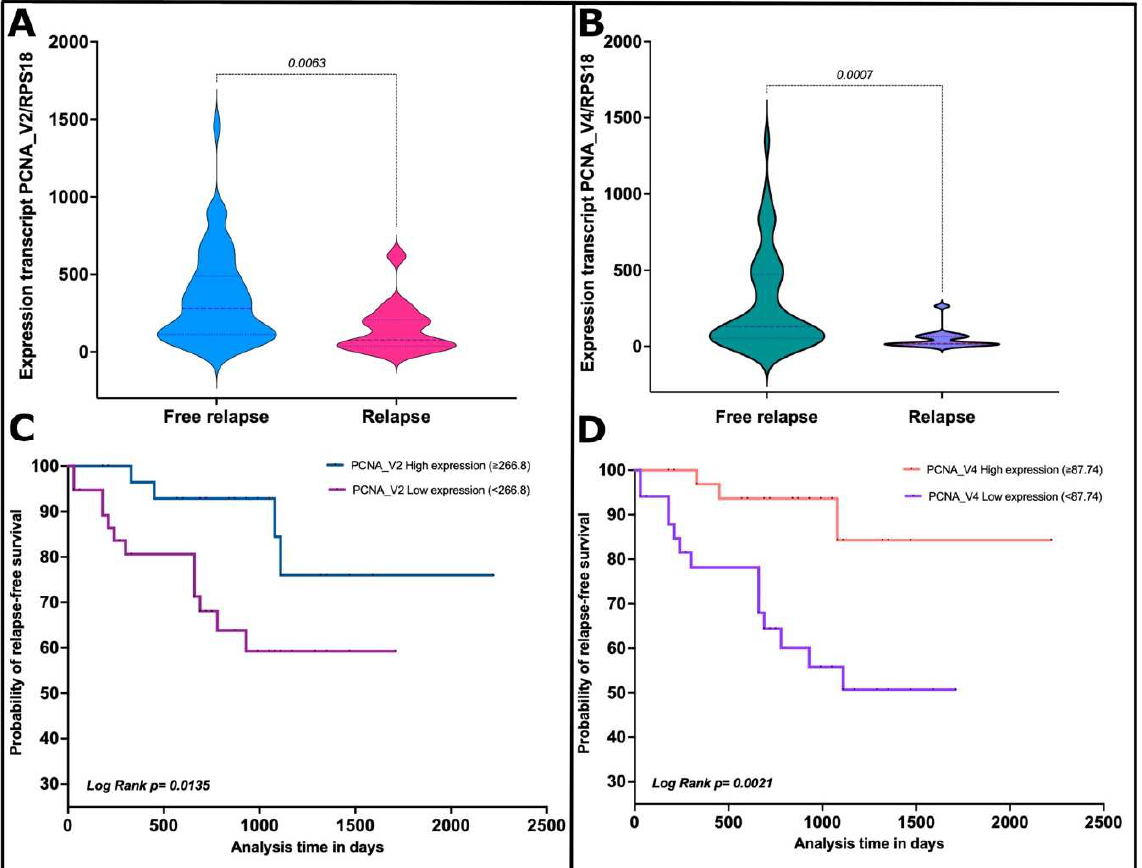
Figure 9. PCNA_V2 and PCNA_V4 transcript variant expression is a potential predictor of relapse in B-ALL. The plot shows the absolute gene expression of the PCNA transcript variants normalized vs. housekeeping RPS18 transcript. ( A ) The y -axis shows the expression levels of PCNA_V2. The x -axis shows the patient groups: blue = free relapse patients and pink = relapse patients. The relapsed patients showed a significant reduction in PCNA_V2 expression vs. free relapse ( p value = 0.0063;